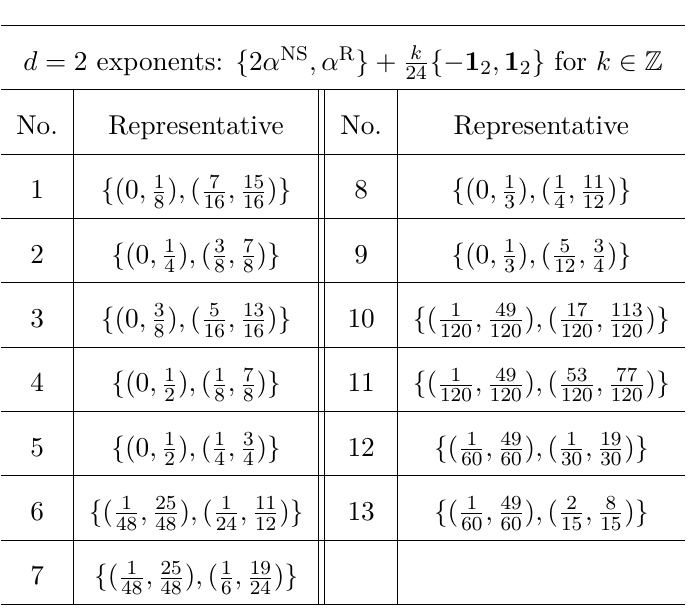
Table 8 . All possible exponents mod 1 for rank 2 non-degenerate FRCFTs.